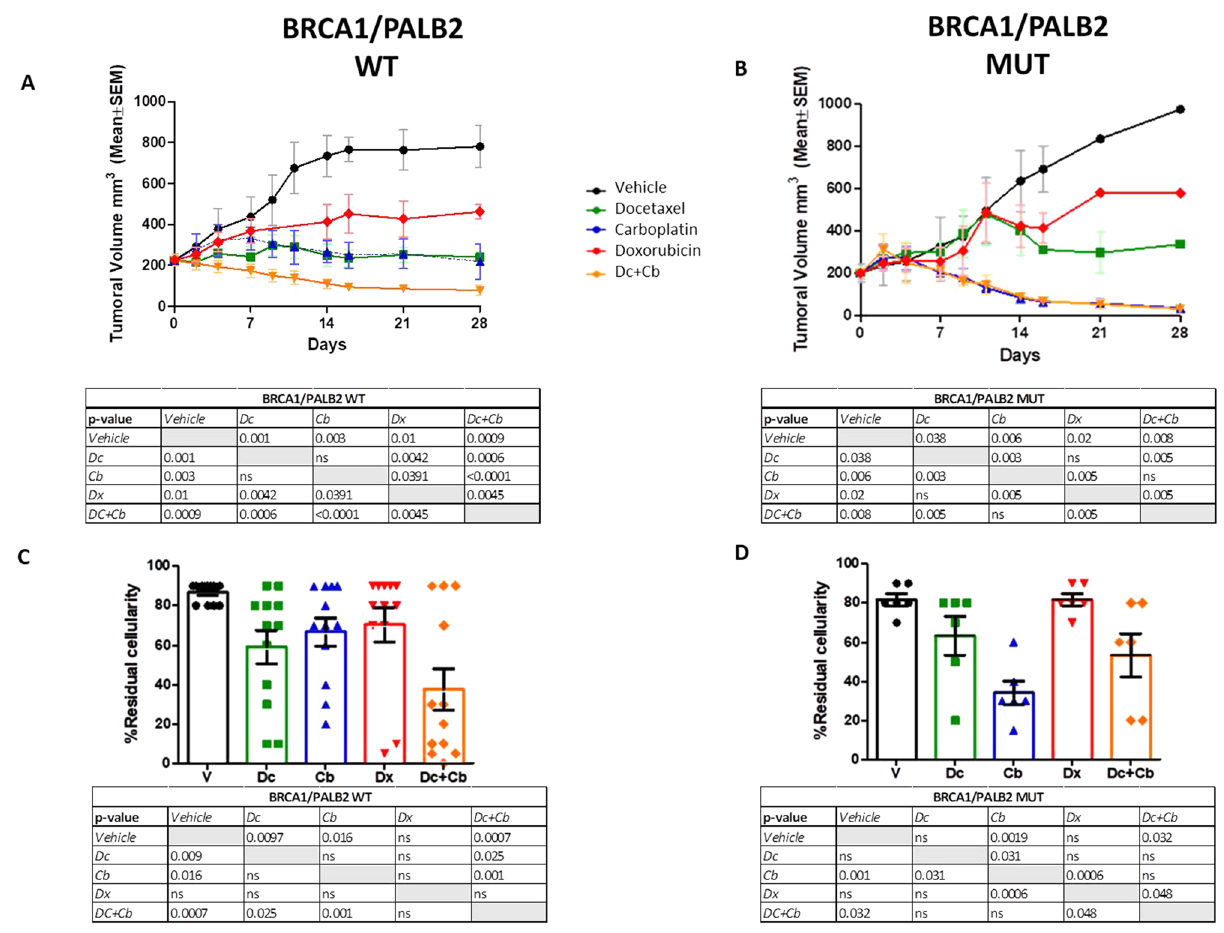
Figure 1. Tumor volume evolution (panels A and B) and residual cellularity (panels C and D) in PDX from patients with and without mutations in genes involved in homologous recombination. ns, nonsignificant; * p < 0.05; ** p < 0.005; *** p < 0.0005; Dc, docetaxel; Cb, carboplatin; V, vehicle; Dx, doxorubicin; Dc + Cb: docetaxel plus